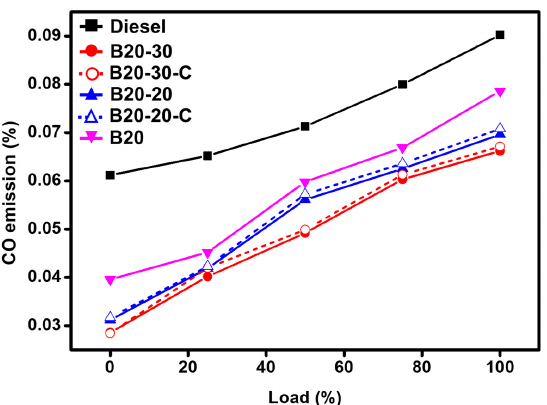
Figure 8. Comparative graphical illustration of emission of CO from diesel and blends vs. load (%) (with ZnO-GS and ZnO-C). B20 is D-COME, i.e., discarded cooking oil methyl ester, which is blended with 20% commercial diesel; B20-20 is the blend of B20 with 20 mg of ZnO-GS/C; B20-30 is the blend of B20 with 30 mg of ZnO-GS/C.